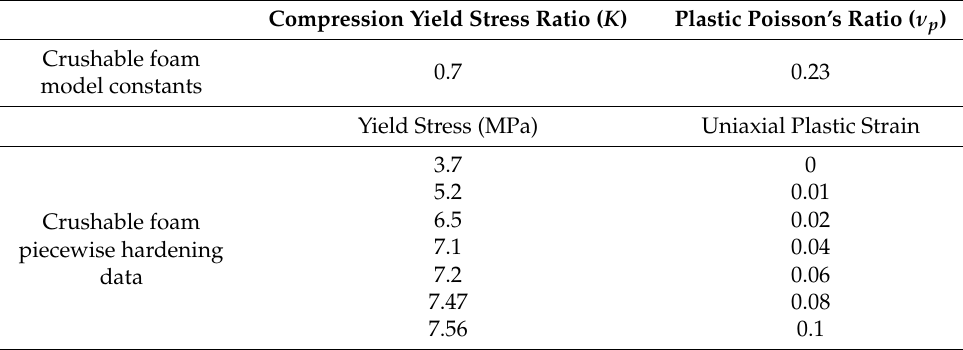
Table 2. Isotropic crushable foam plasticity model material parameters for PU20.